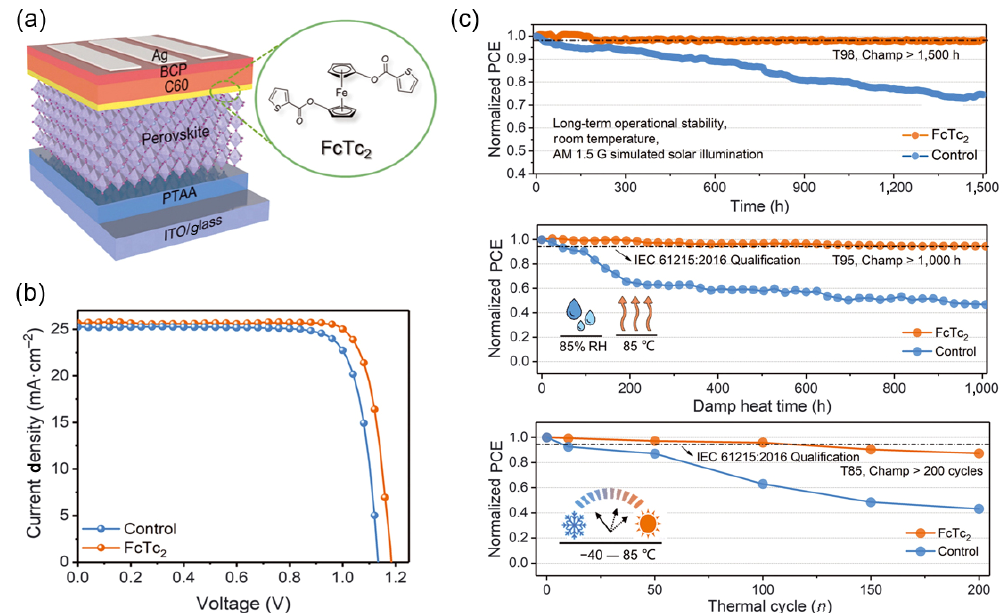
Figure 2 (a) Schematic illustration of inverted PSC with FcTc 2 as the interface functionalization material. (b) J – V curves of PSCs with and without FcTc 2 . (c) Stability measurements of PSCs with and without FcTc 2